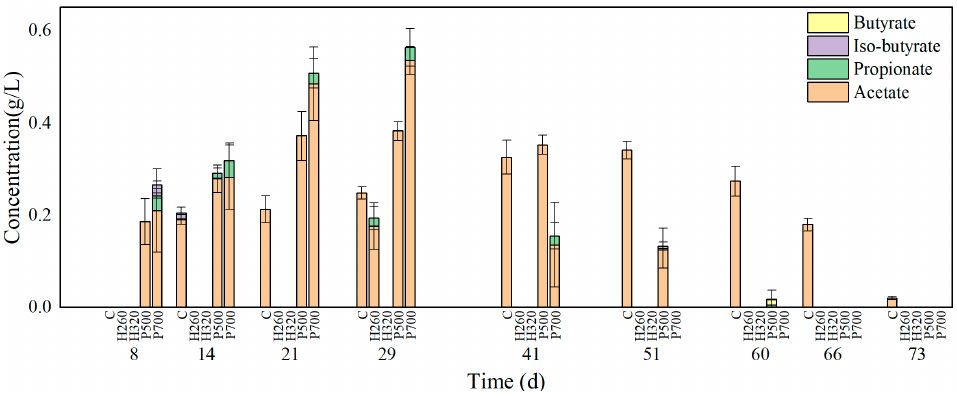
Figure 3. Changes of VFA concentration after adding H260, H320, P500, and P700.